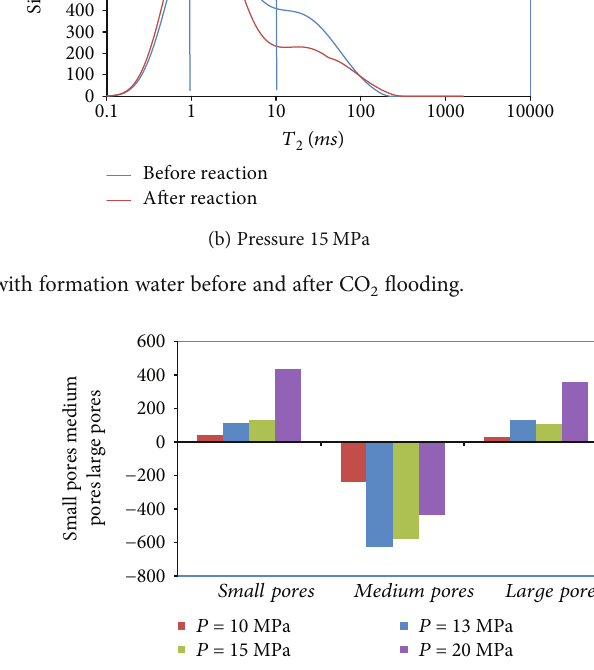
Figure 13: Probability distribution of cores saturated with formation water under di ff erent pressures before and after CO